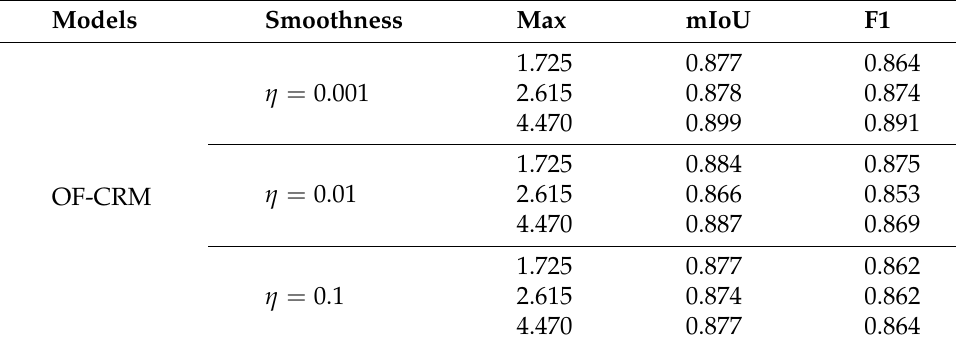
Table 2. Quantitative comparison of different models. Our model outperforms the optical filter design without color-ratio maps and no filter settings in the test dataset. The minimum value in Equation (4) is the same in all settings (min =